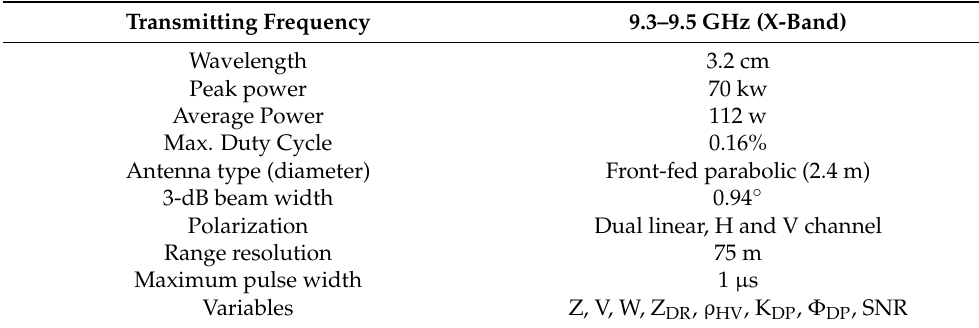
Table 1. Specification of X-POL